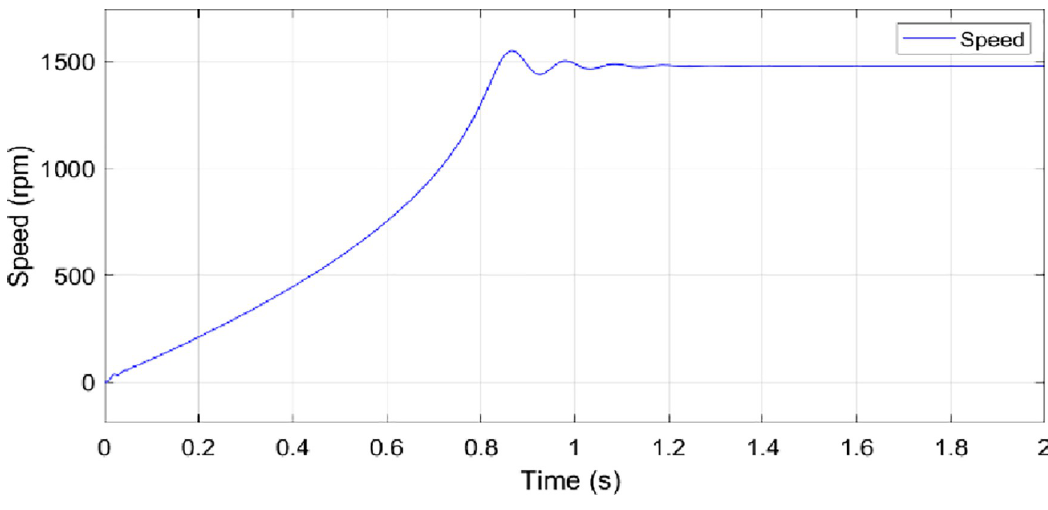
voltage is fed into the electrical model to simulate the current trend. The simulated current is plotted together with the actual current to verify the performance of the three-phase induction motor model as illustrated in Fig